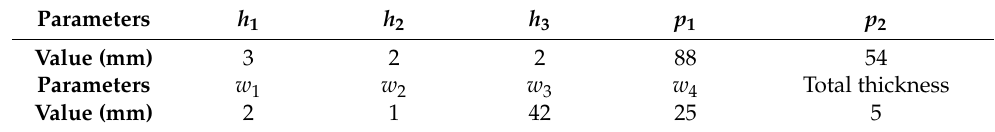
Figure 2. ( a ) Perspective view of the designed unit cell with a total thickness of 5 mm. ( b ) The construction of the unit cell of the proposed metamaterial absorber. ( c ) Top view of the upper layer. ( d ) Back view of the upper layer. Table 1. Parameters of the proposed MMA.